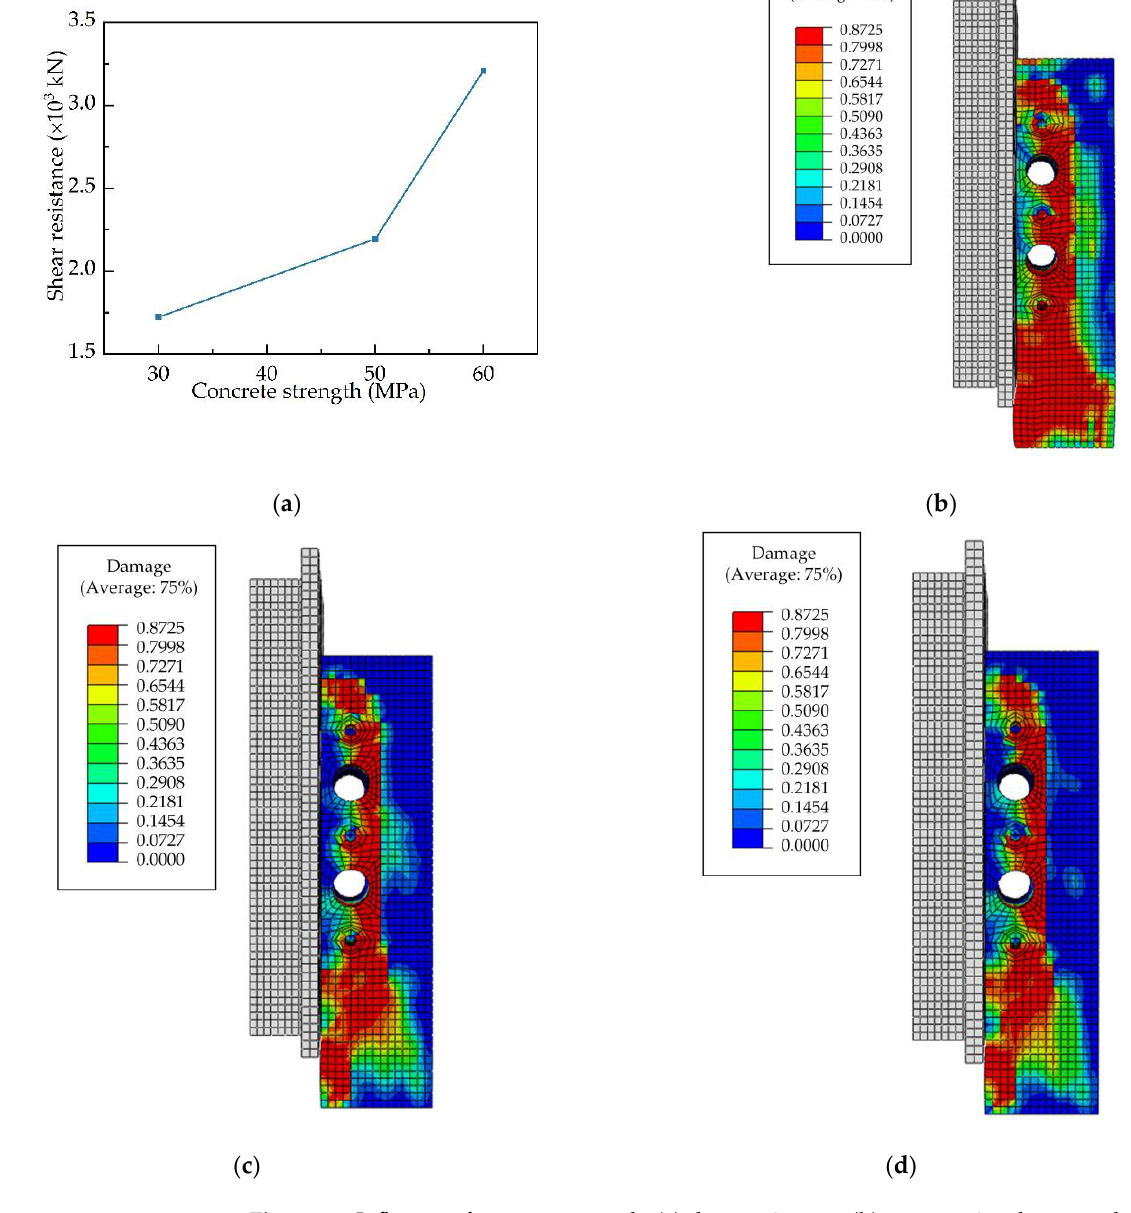
Figure 20. Influence of concrete strength: ( a ) shear resistance; ( b ) compressive damages cloud map of C30 concrete; ( c ) compressive damages cloud map of C50 concrete; ( d ) compressive damages cloud map of C60 concrete.